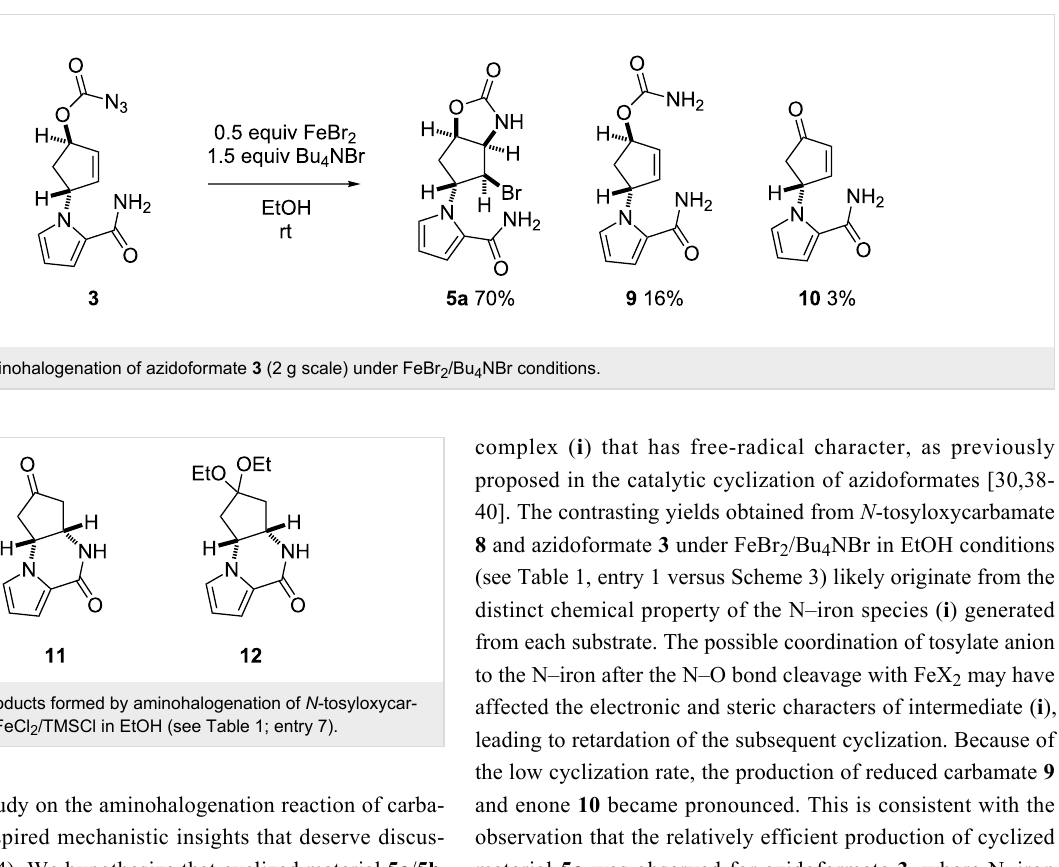
The present study on the aminohalogenation reaction of